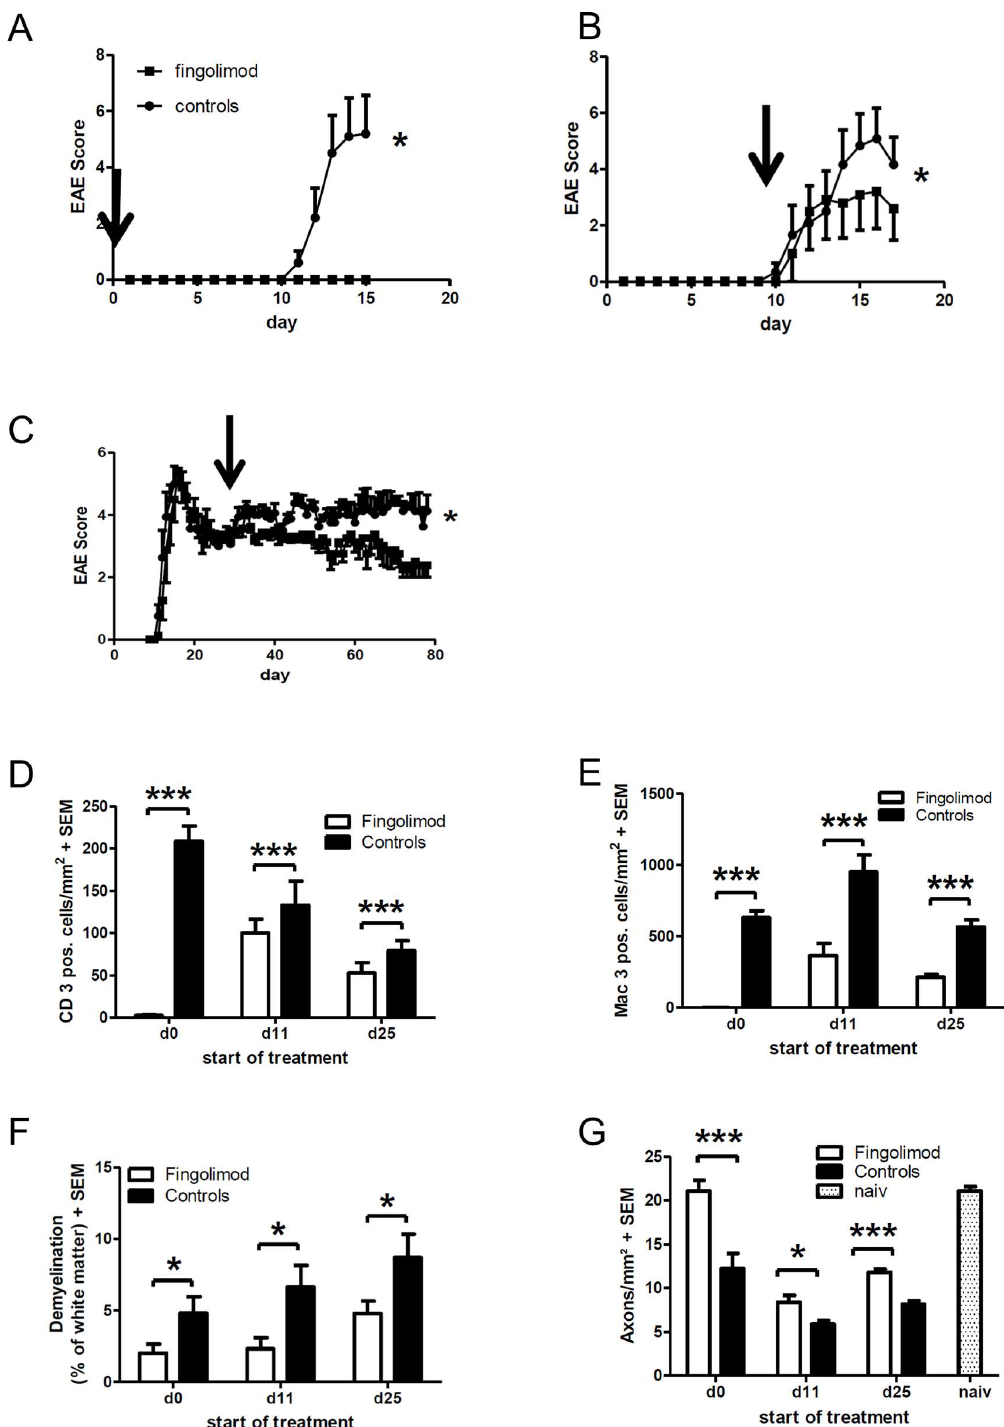
Fig 2. Clinical course and blinded histpathological analysis of inflammation and degeneration after treatment of MOG-EAE with fingolimod at 3 mg/kg/d. (A) Clinicalcourseo f EAE after prophylactic treatment starting from day 0 after immunization (n = 6 per group). (B) Treatment initiationat the beginningof disease(day 11 p.i., n = 6 per group). (C) Treatment initiationat the early chronicphaseof the disease(day 25 p.i., n = 8 per group). (D-G) Blindedhistopathological quantification of spinal cord cross sectionsafter staining for (D) CD3 positive T cells, (E) Mac-3 positive macrophages and microglia, (F) demyelination with the Luxol Fast Blue technique, and (G) axonal